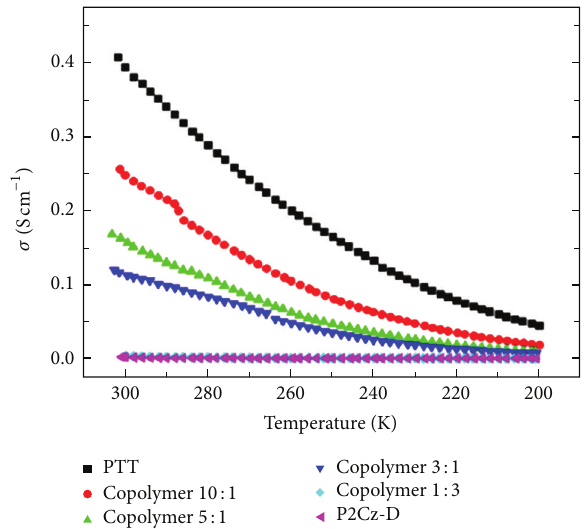
Figure 4: Temperature dependence of electrical conductivities for polythieno[3,2-b]thiophene (PTT), poly(1,12-bis(carbazolyl)dodec- ane) (P2Cz-D), and copolymers synthesized with monomer feed ratios of TT/2Cz-D = 10 : 1, 5: 1, 3 :1, and 1:3 in boron trifluoride diethyl etherate (BFEE) + dichloromethane (DCM) (30% vol) [19].